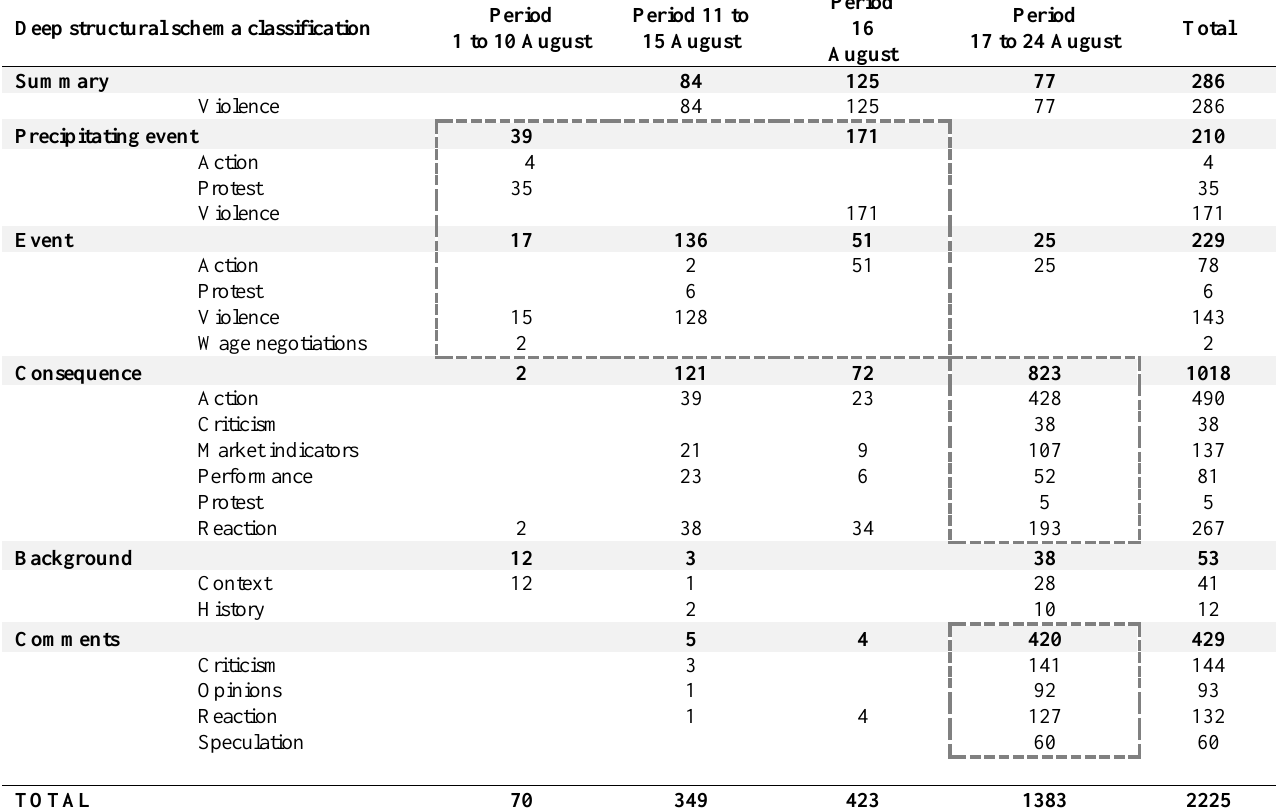
Table 1: Data count by Deep Structural Schema and time-period Deep structural schema